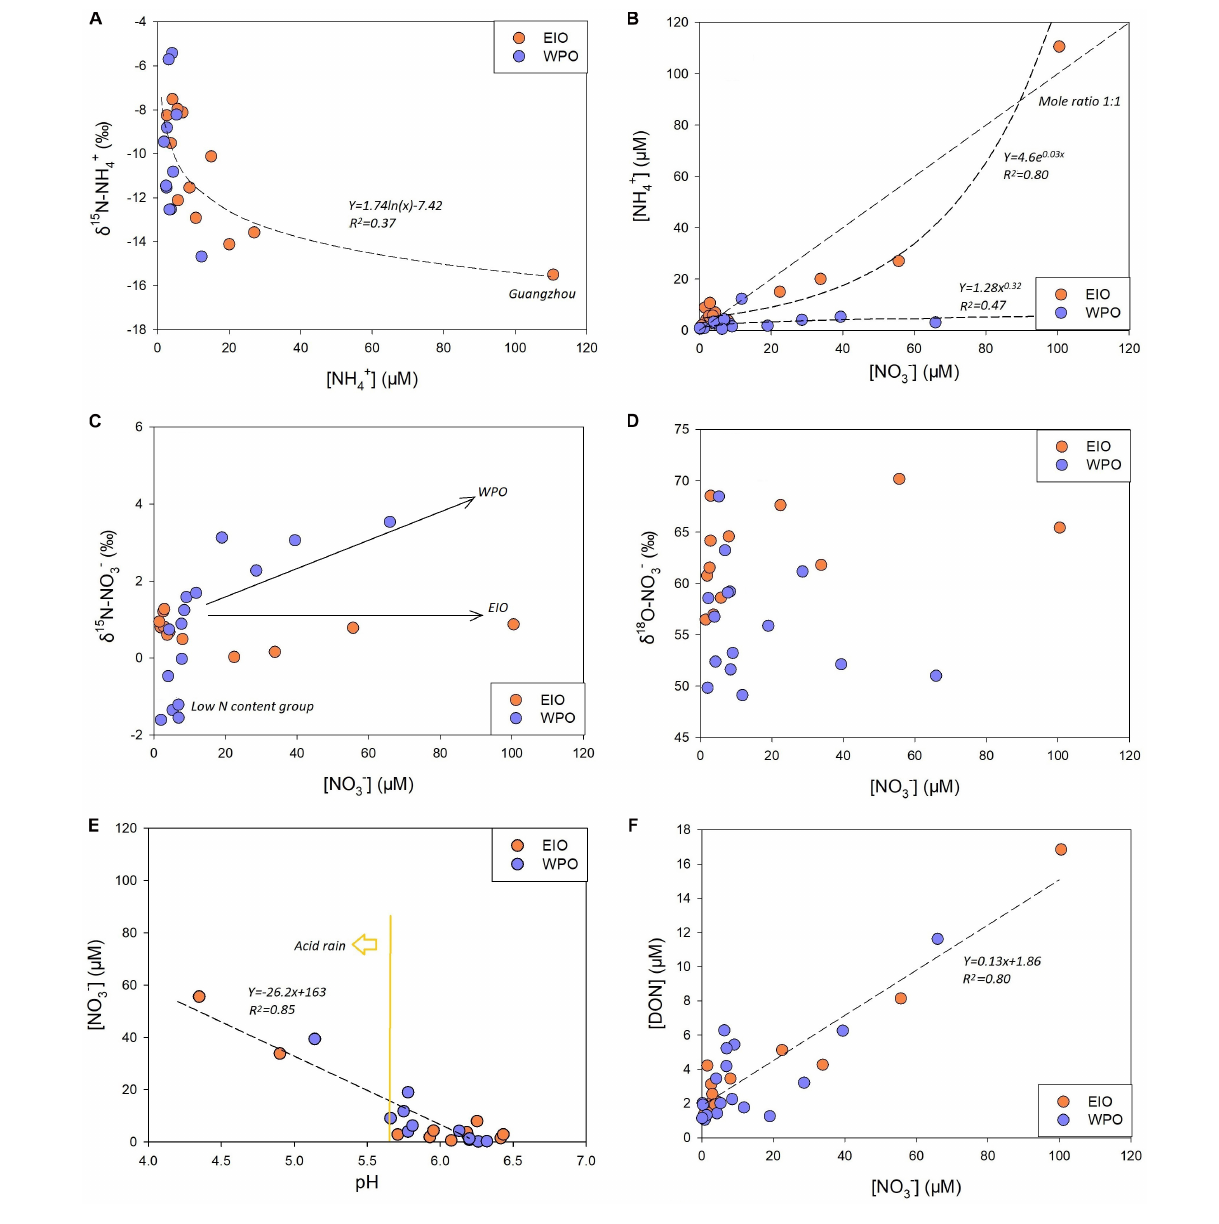
FIGURE 3 | (A) Correlation between NH 4 + concentration and δ 15 N–NH 4 + . (B) Correlation between NH 4 + and NO 3 - concentrations in rainwater, showing significantly different curves between two oceans. (C,D) The insignificant trend between NO 3 - concentration and δ 15 N/ 18 O–NO 3 - . (E,F) Correlation between pH/DON and NO 3 - concentrations in rainwater from two